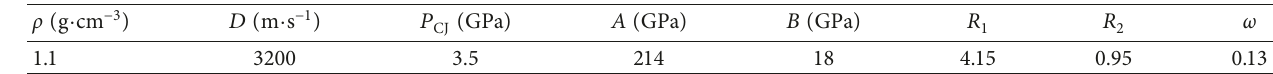
Figure 2: Finite element model: (I) rock; (II) explosive; (III) air; (IV) slotted pipe. Table 1: Parameters of explosives.